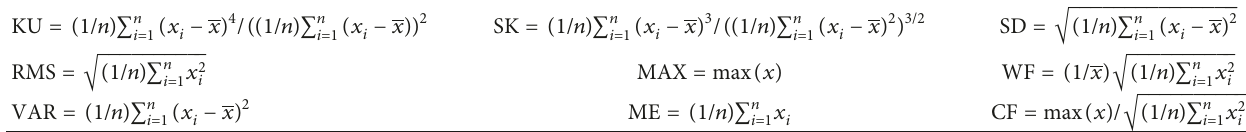
Table 1: Statistical